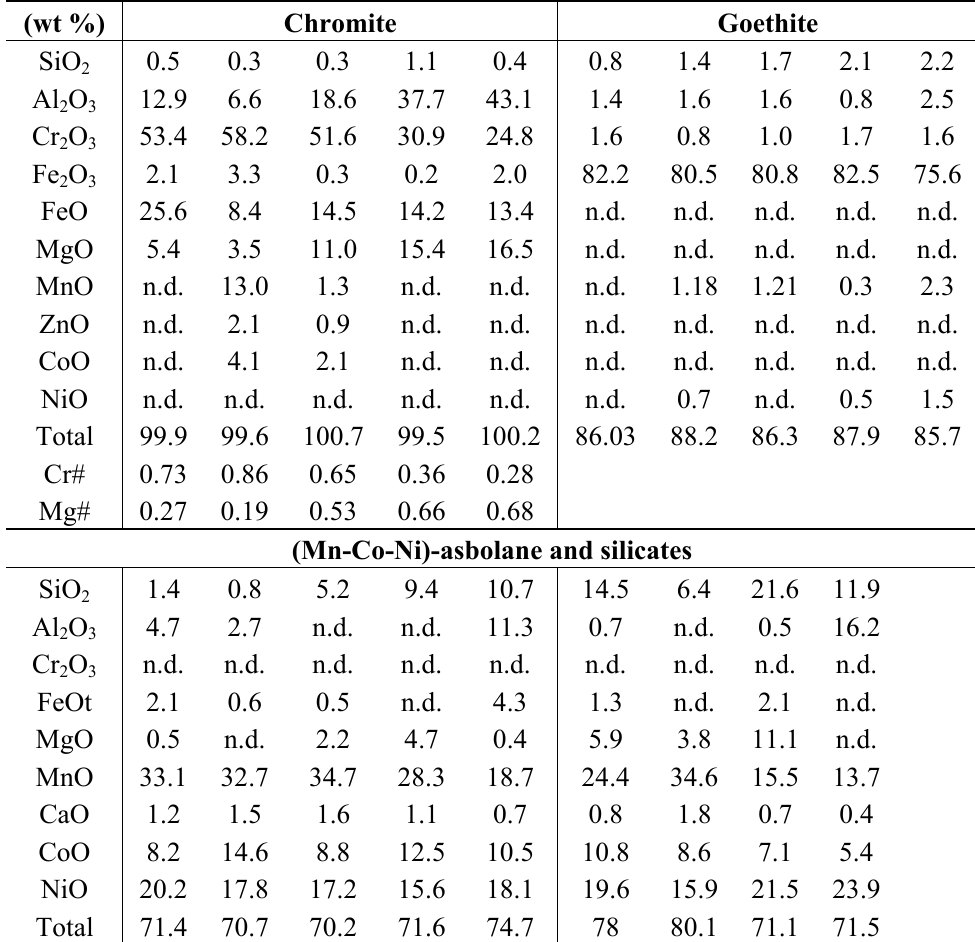
Table 2. Representative microprobe analyses of oxides and silicates from soils.